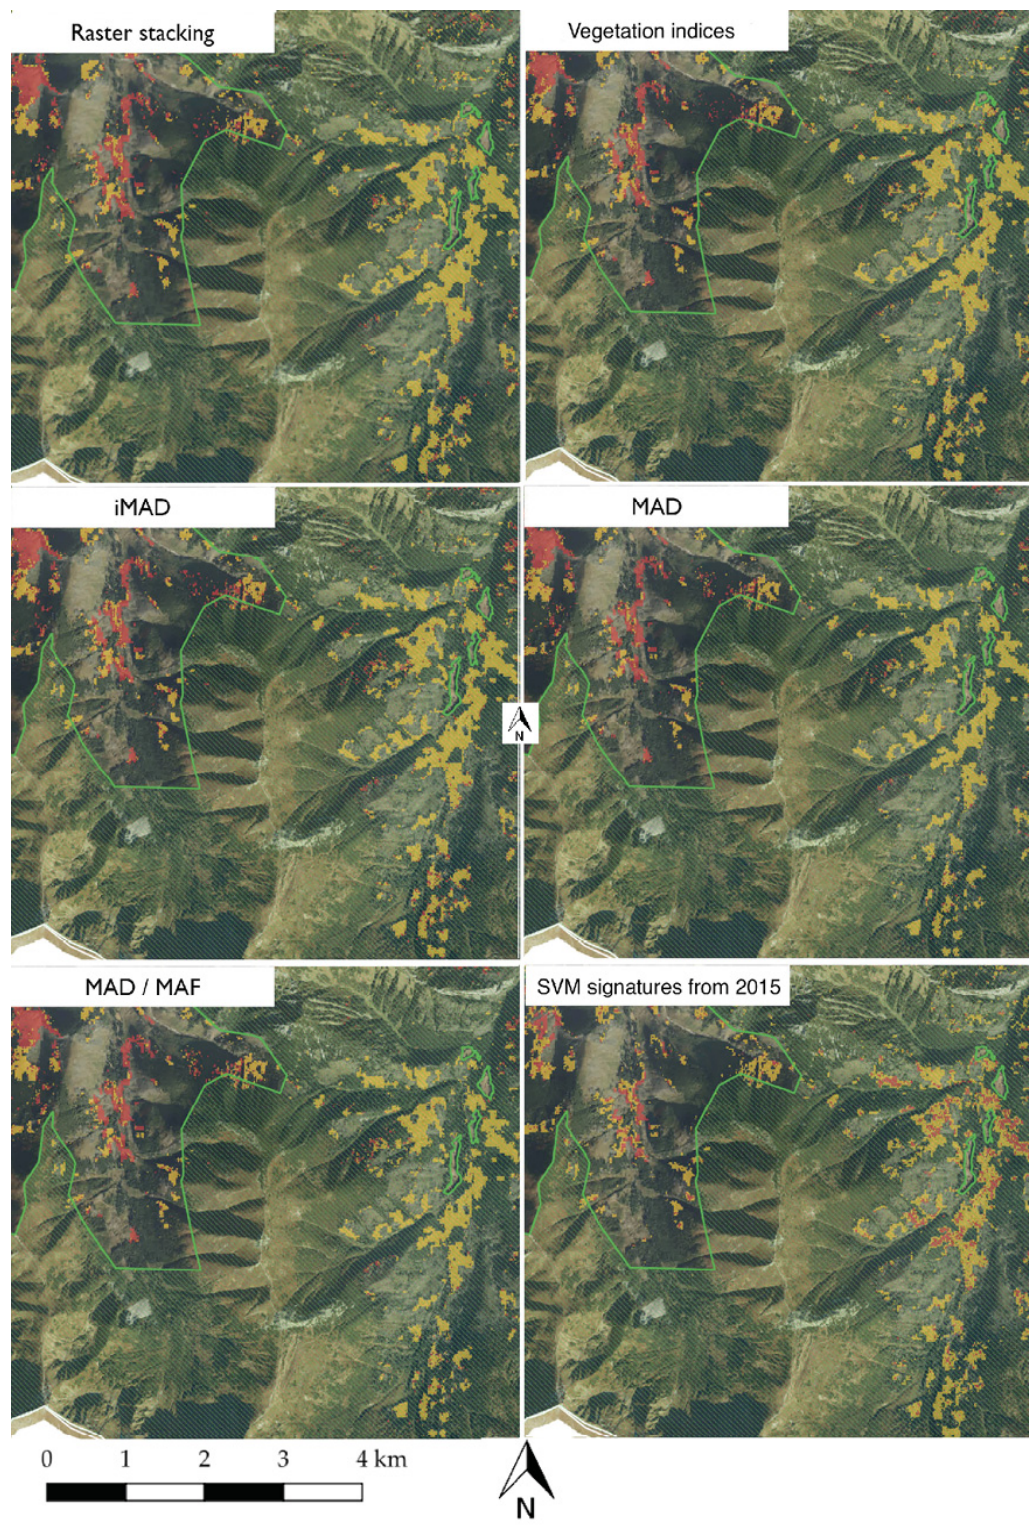
Figure 4. A visual presentation of the results obtained from used algorithms on a fragment of the Sentinel-2 scene. Fresh snags are marked in yellow (mainly as a result of bark beetle outbreak), and the cuts/windthrow area class in red. The green line marks the area of strict protection of the Tatra National Park. The geographical range of the image is presented on Figure 1; background: orthophotomap from 2017.